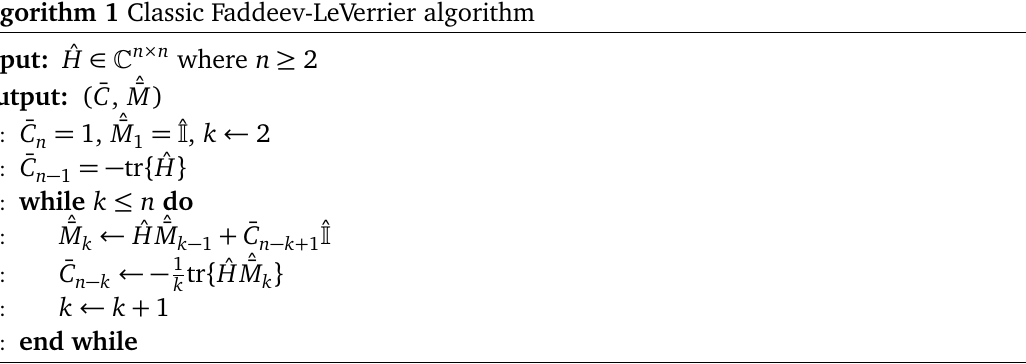
Algorithm 1 Classic Faddeev-LeVerrier